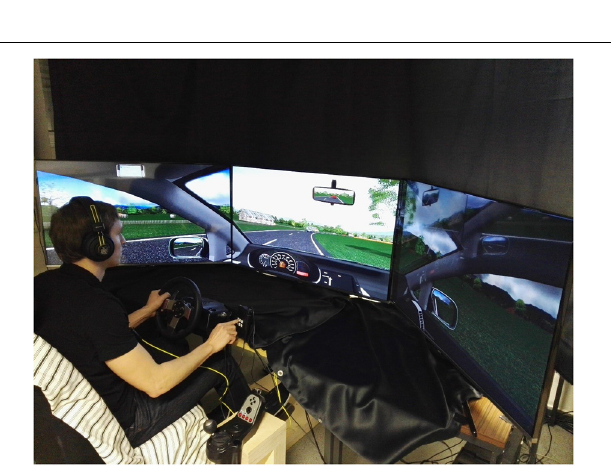
FIGURE 2 | Driving simulator